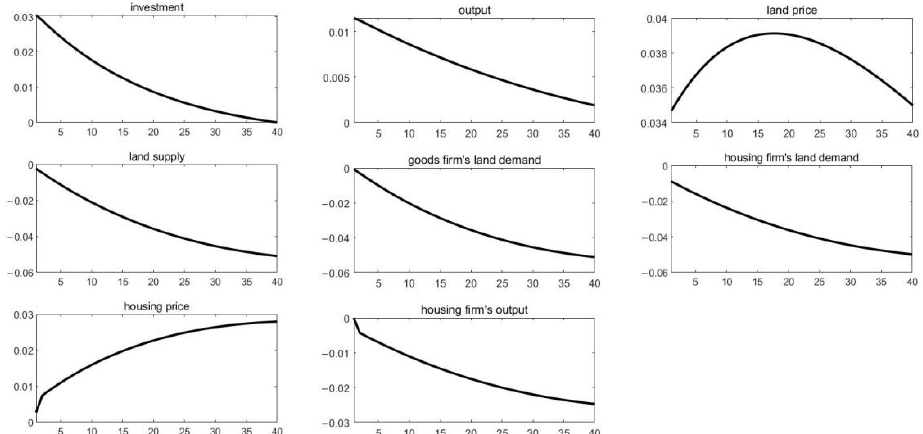
Figure 5. Impulse responses to a positive (one standard deviation) TFP shock (endogenous land, γ= 1). γ = 1).